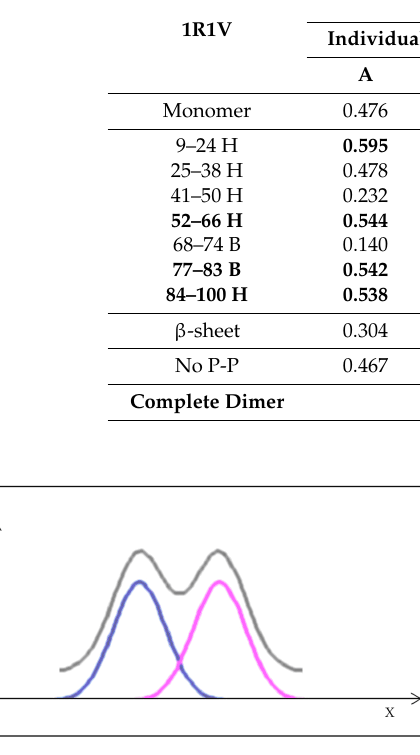
Figure 4. Schematic depiction of a system in which the dimer lacks a clear hydrophobic core while each monomer retains a well-defined core. Elimination of residues involved in complexation (right-hand image) leads to better accordance with the model when considering the dimer as a whole. Blue and pink lines: distributions in monomers, gray line: distribution in dimer. ( A ) Status of the individual monomers ( blue and pink ) versus the resultant distribution in dimer ( gray ); ( B ) Removal of the interface ( black bar ) changes the status of the dimer—Distribution appears accordant versus the expected one.